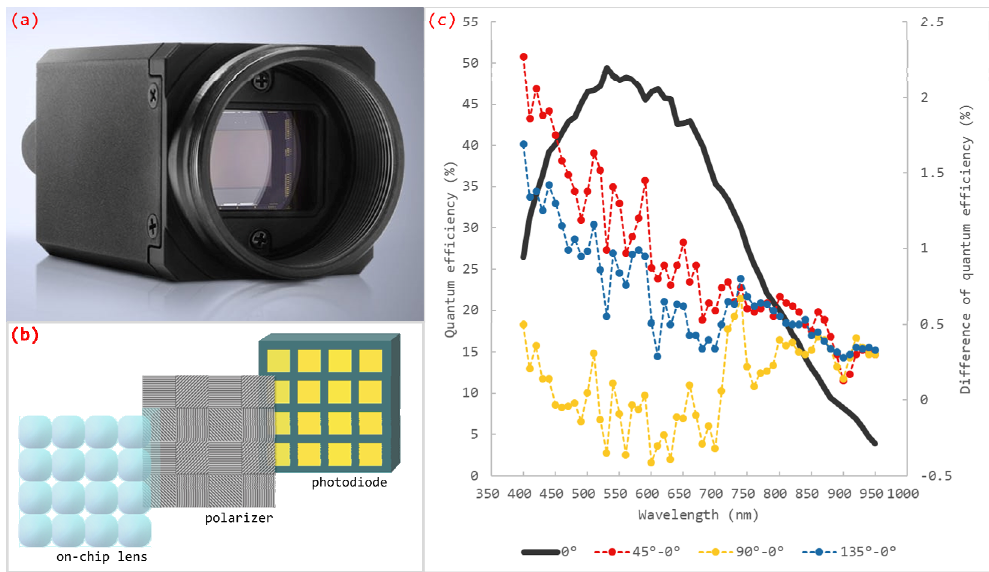
Figure 1. Monochrome polarization sensor (LUCID